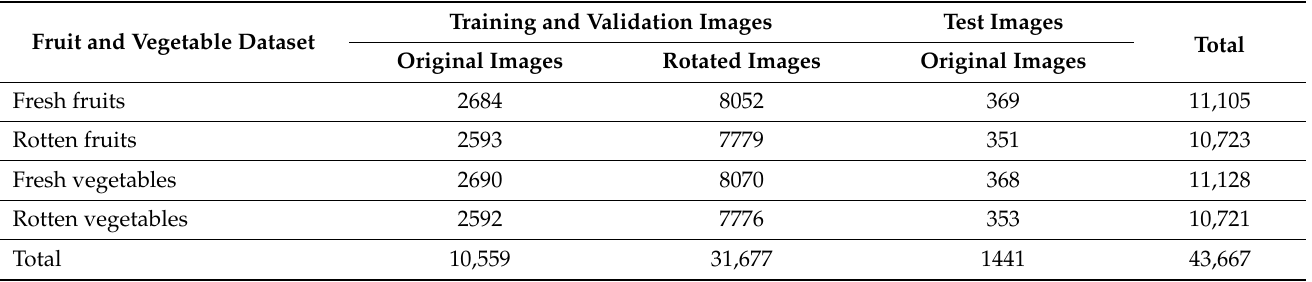
Table 3. Distribution of training and testing images in the fruit and vegetable classification dataset.